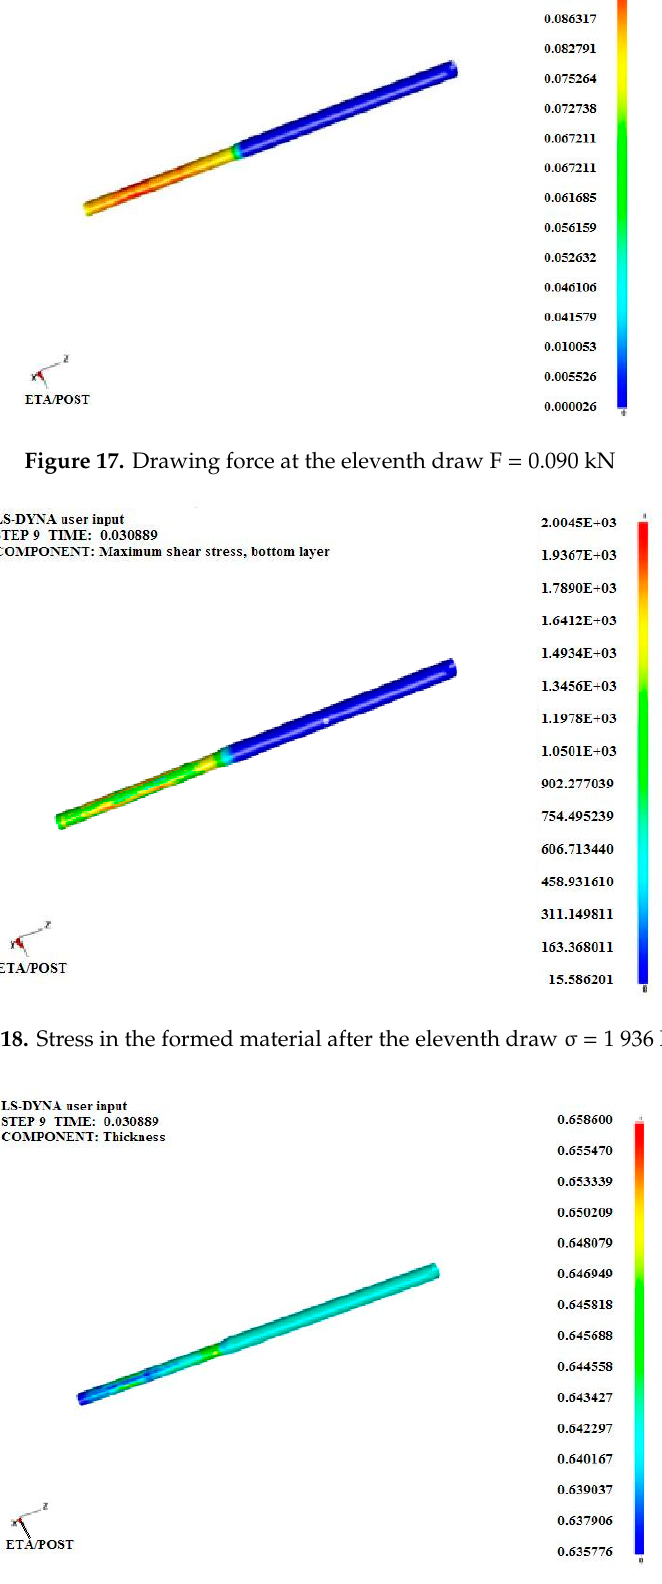
90 Table 6. Comparison table of calculated and simulated values of effective stresses in the formed material.